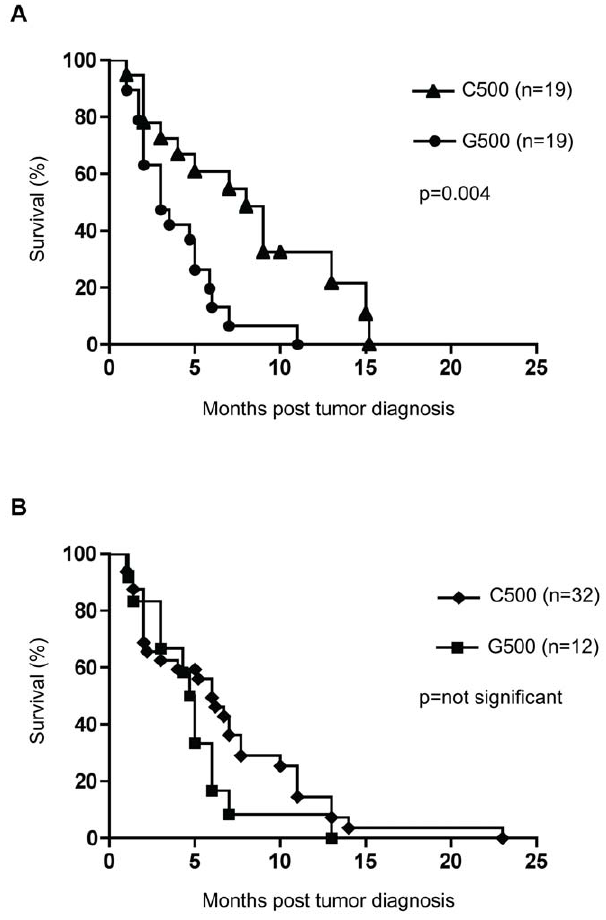
Figure 1. Patient survival with the G500 allele compared to C500 homozygotes for individuals with NDTMM and telome- rase positive GBMs. A. Kaplan-Meier survival analysis post tumor diagnosis for individuals with GBMs with no defined telomere maintenance mechanism (NDTMM). Survival data was available for all 38 individuals (the G500 homozygotes were excluded from the analysis). B. Kaplan-Meier survival analysis post tumor diagnosis for individuals with telomerase positive GBMs. Survival data was available for 44 individuals. Individuals genotyped as heterozygote for the C500G polymorphism (G500) in the 3 9 CDKN2A UTR were associated with reduced survival compared to C500 homozygotes (C500) using a multi- variant Cox proportional hazards regression analysis (Table